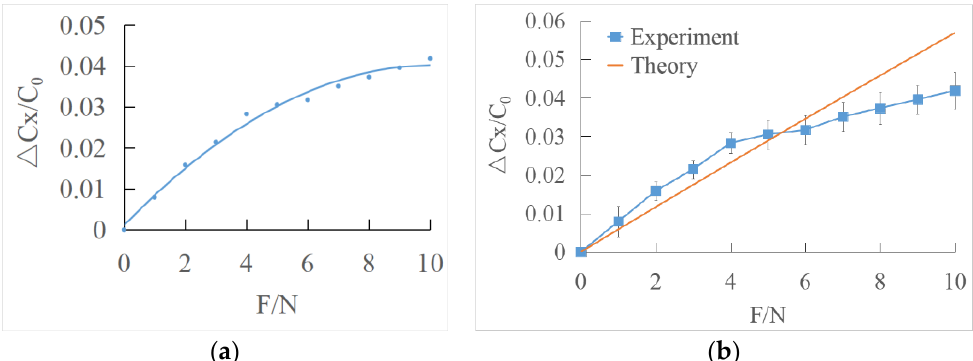
Figure 14. ( a ) Least squares fitting the output characteristic curve of tangential force direction; ( b ) comparison of experimental data and theoretical data under shear force loading.